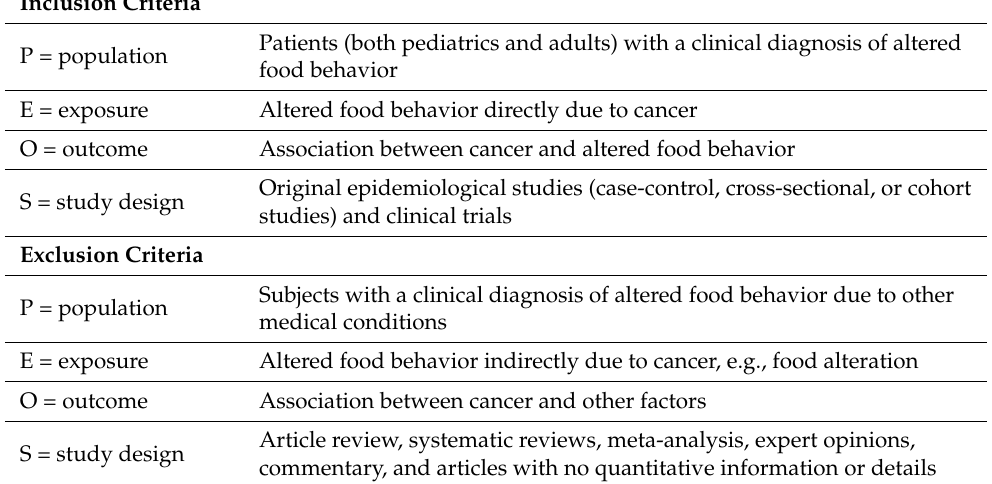
Table 1. Detailed description of inclusion and exclusion criteria based on a Population, Exposure, Outcomes, and Study Design